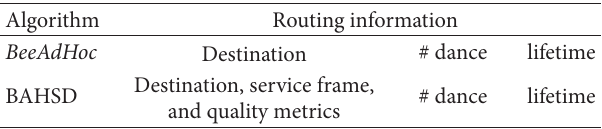
Table 2: BAHSD and BeeAdHoc entries in the dance floor. Algorithm Routing